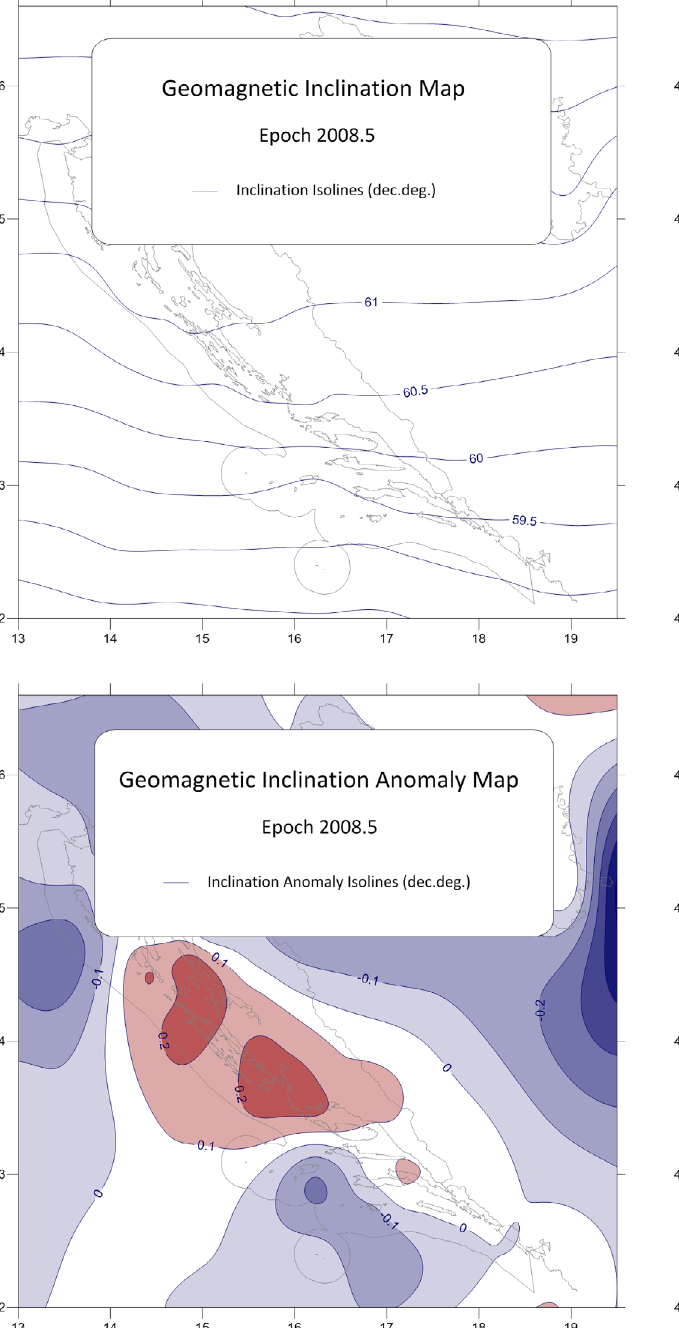
Figure 5 (above, top and bottom). Total intensity and its anomaly at 2008.5. Figure 4 (above, top and bottom). Inclination and its anomaly at